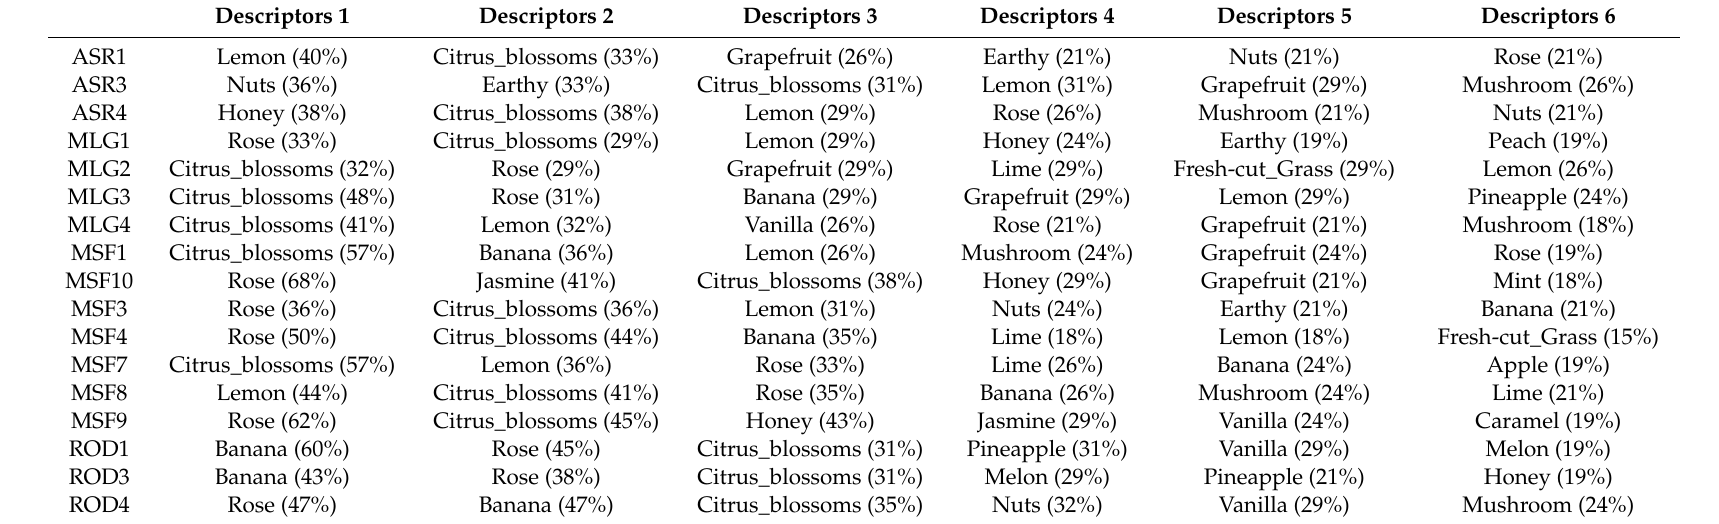
Table 6. The six most frequently selected descriptors (proportion of selection in parenthesis) by the panel for each